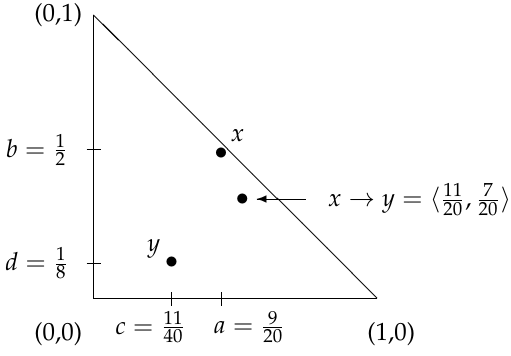
Figure 4. The geometrical interpretations of elements x , y and x → y : third scenario.